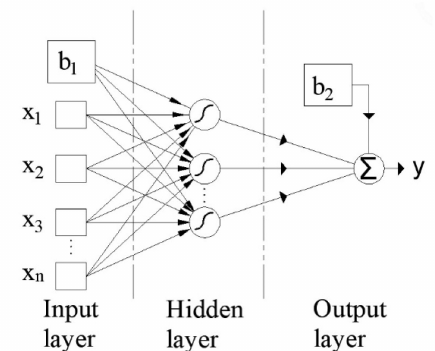
Figure 1. Schematic representation of a multi-layer perceptron neural network